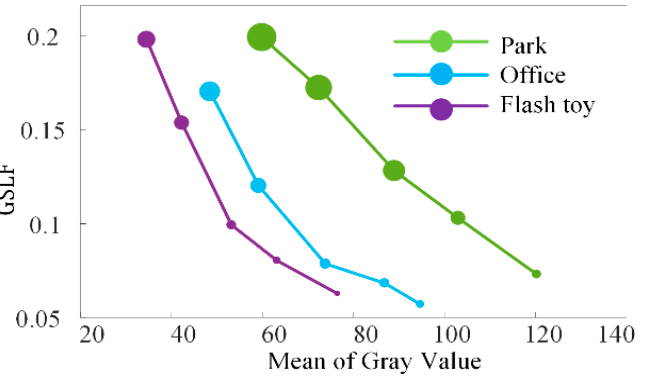
Figure 14. Flash toy. ( a ) Input different global illumination image sequences. ( b ) Output almost the same global illumination image sequence.